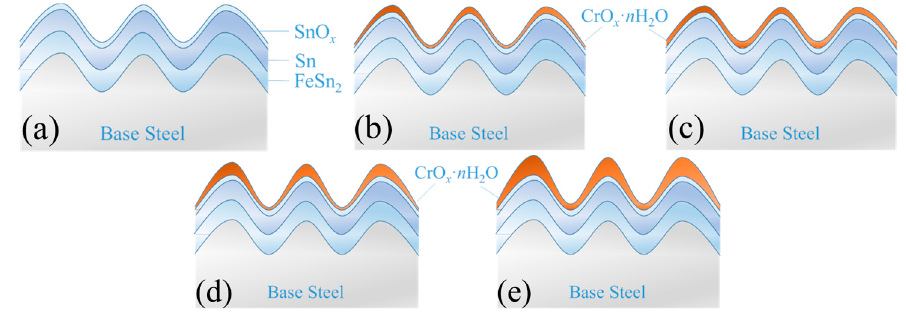
Figure 10. Schematic diagram of structure models of the tinplate treated with ( a ) reflowing before passivation; ( b , c ) chemical passivation for 3 s and 6 s, respectively; and ( d , e ) electrolytic passivation for 3 s and 6 s, respectively.